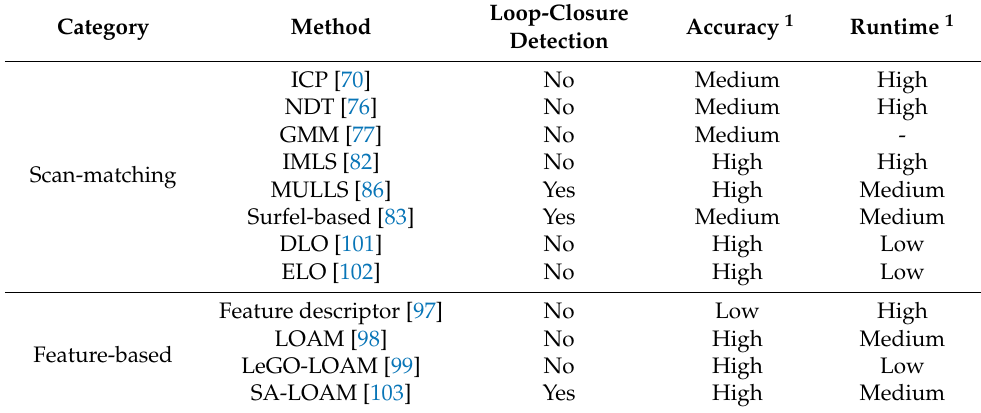
Table 2. Summary of representative LiDAR odometry